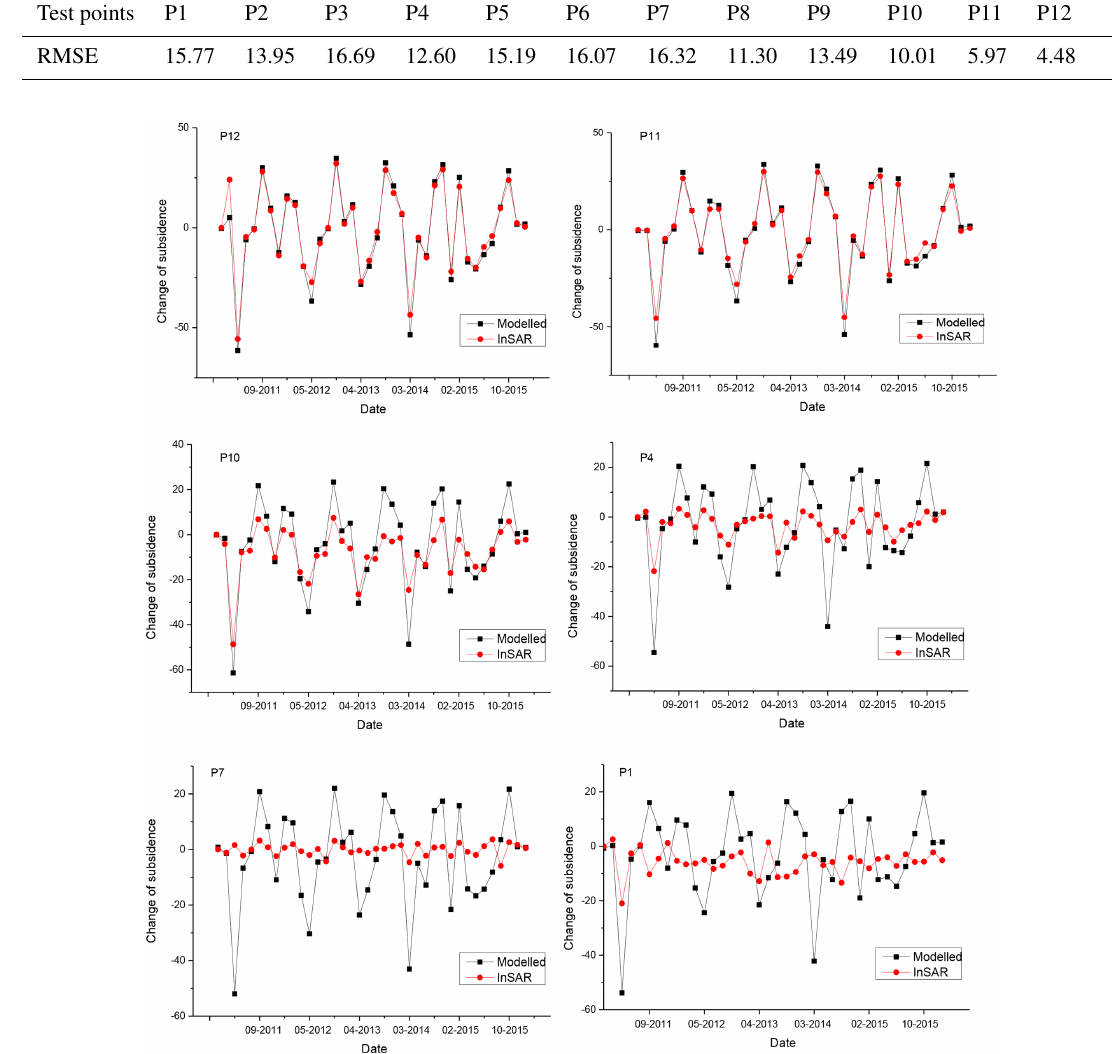
Figure 5. The fit curve between modelled and InSAR-derived change in land subsidence.